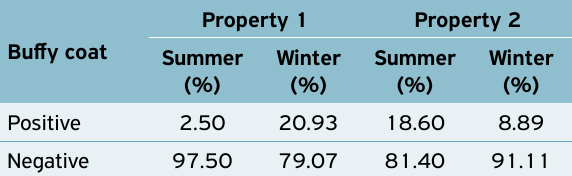
Table 5. Frequency distribution of the presence of intracytoplasmic